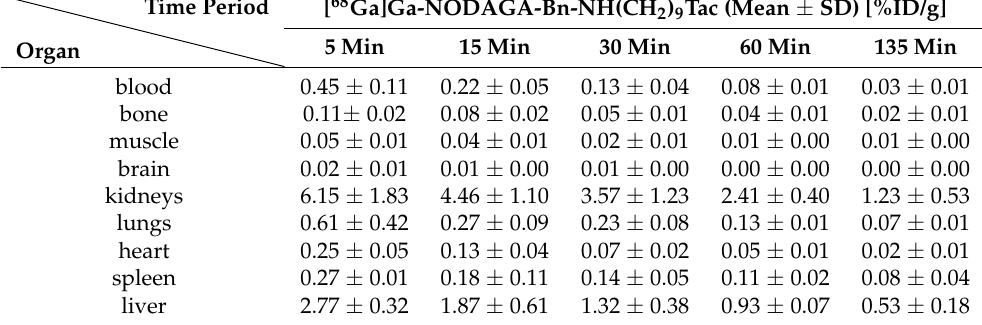
Table 2. [ 68 Ga]Ga-NODAGA-Bn-NH(CH 2 ) 9 Tac uptake in selected rat organs determined after different time periods by ex vivo radioactivity